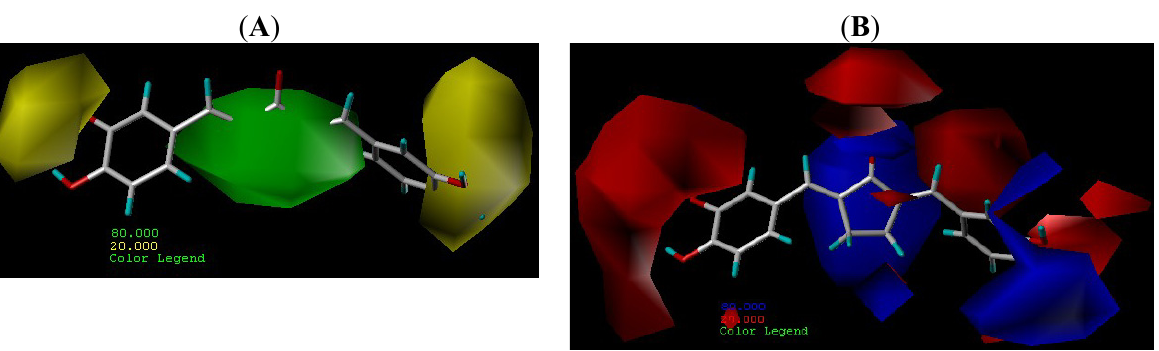
Figure 3. CoMFA steric filed ( A ) and electrostatic field ( B ). S fields: favored (green) and disfavored (yellow); E fields: electropositive (blue) and electronegative